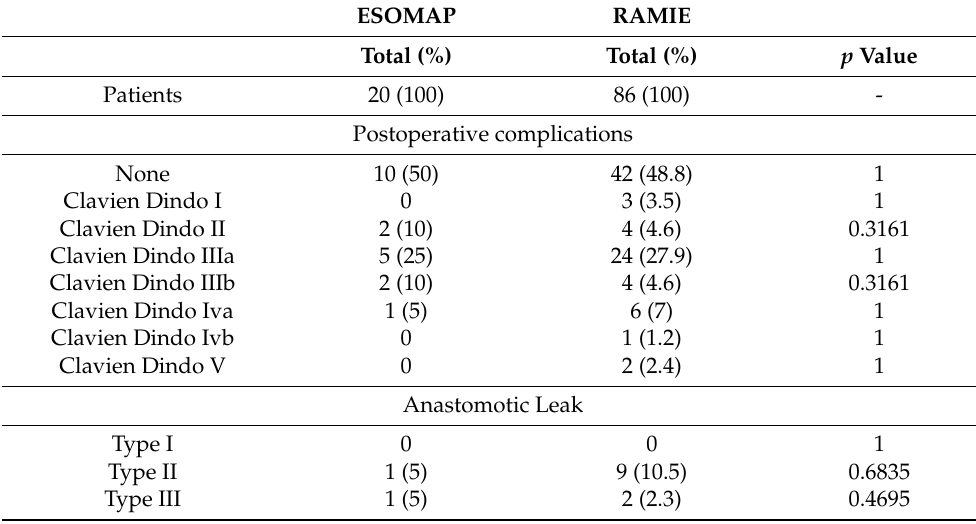
Table 2. Postoperative complications of patients that underwent a RAMIE procedure compared to patients that underwent the ESOMAP protocol in addition to